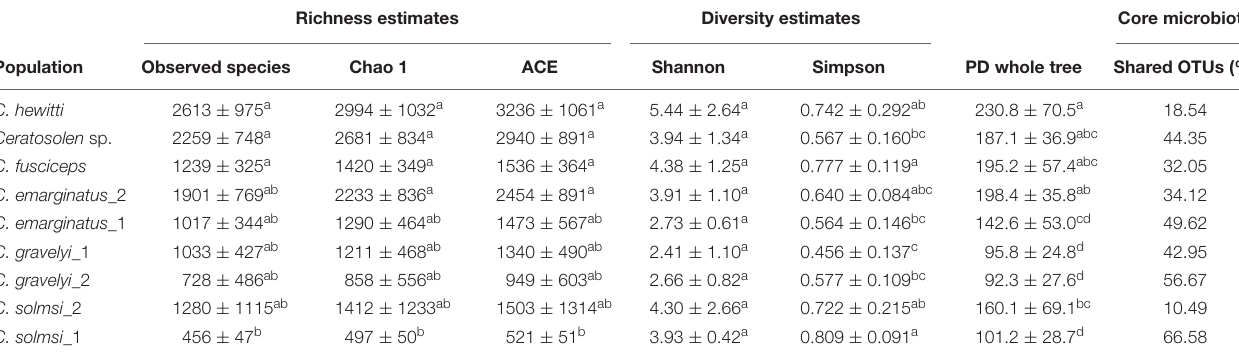
FIGURE 3 | Microbial community composition. Relative abundance of bacteria at the level of phylum (A) and class (B) in nine populations of fig wasp. Three populations in bold are free of Wolbachia ( W –), while the other six populations are infected with Wolbachia ( W +). TABLE 1 | Alpha diversity indices and percentages of shared OTUs among